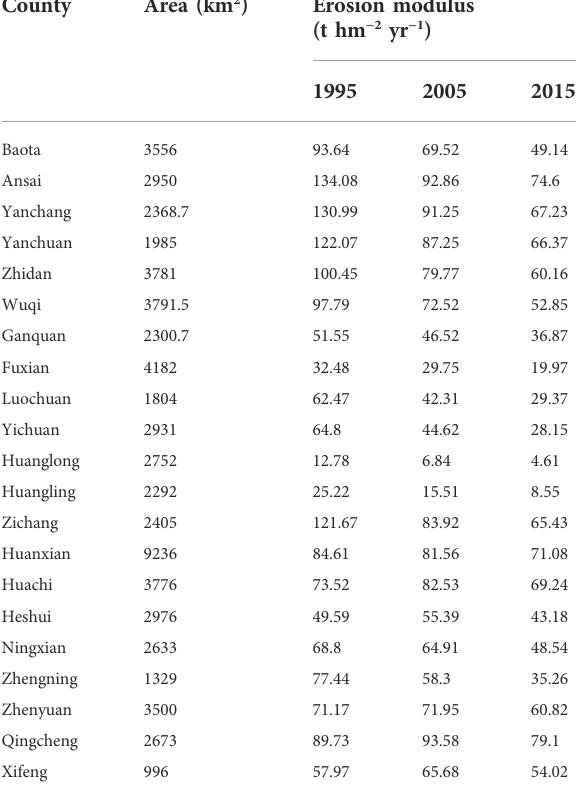
TABLE 2 Erosion modulus of each county from 1995 to